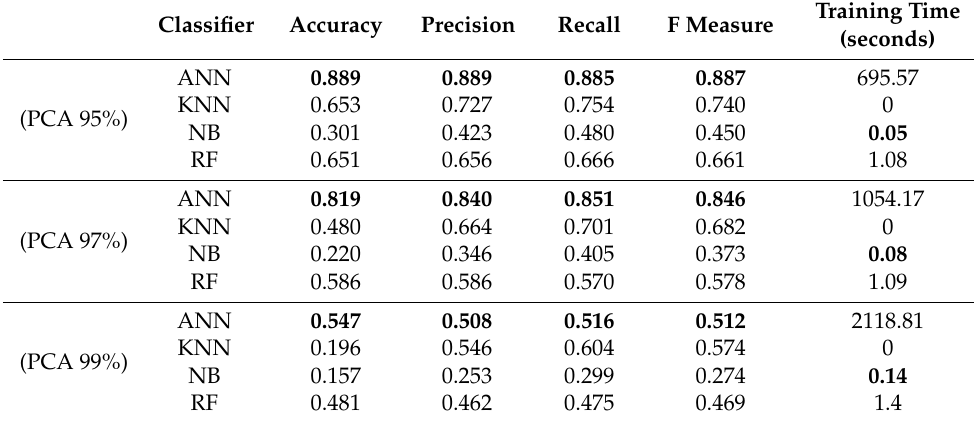
Table 11. Identification results of VGG-19-deep features obtained by minimizing (F6 and F7) after applying PCA. Bold values signify the best performance.